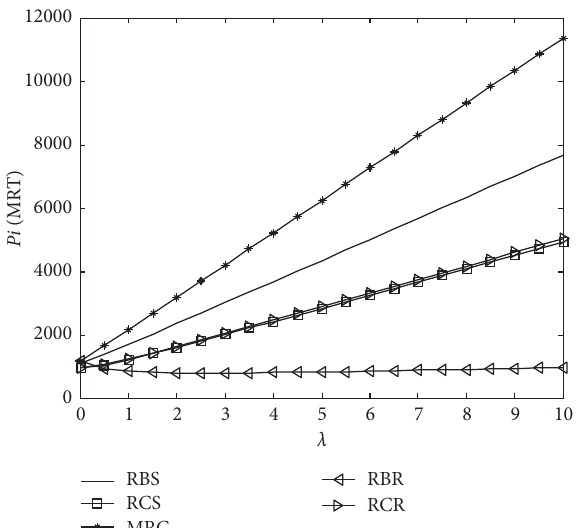
Figure 5: Effect of fairness preference coefficient on the overall